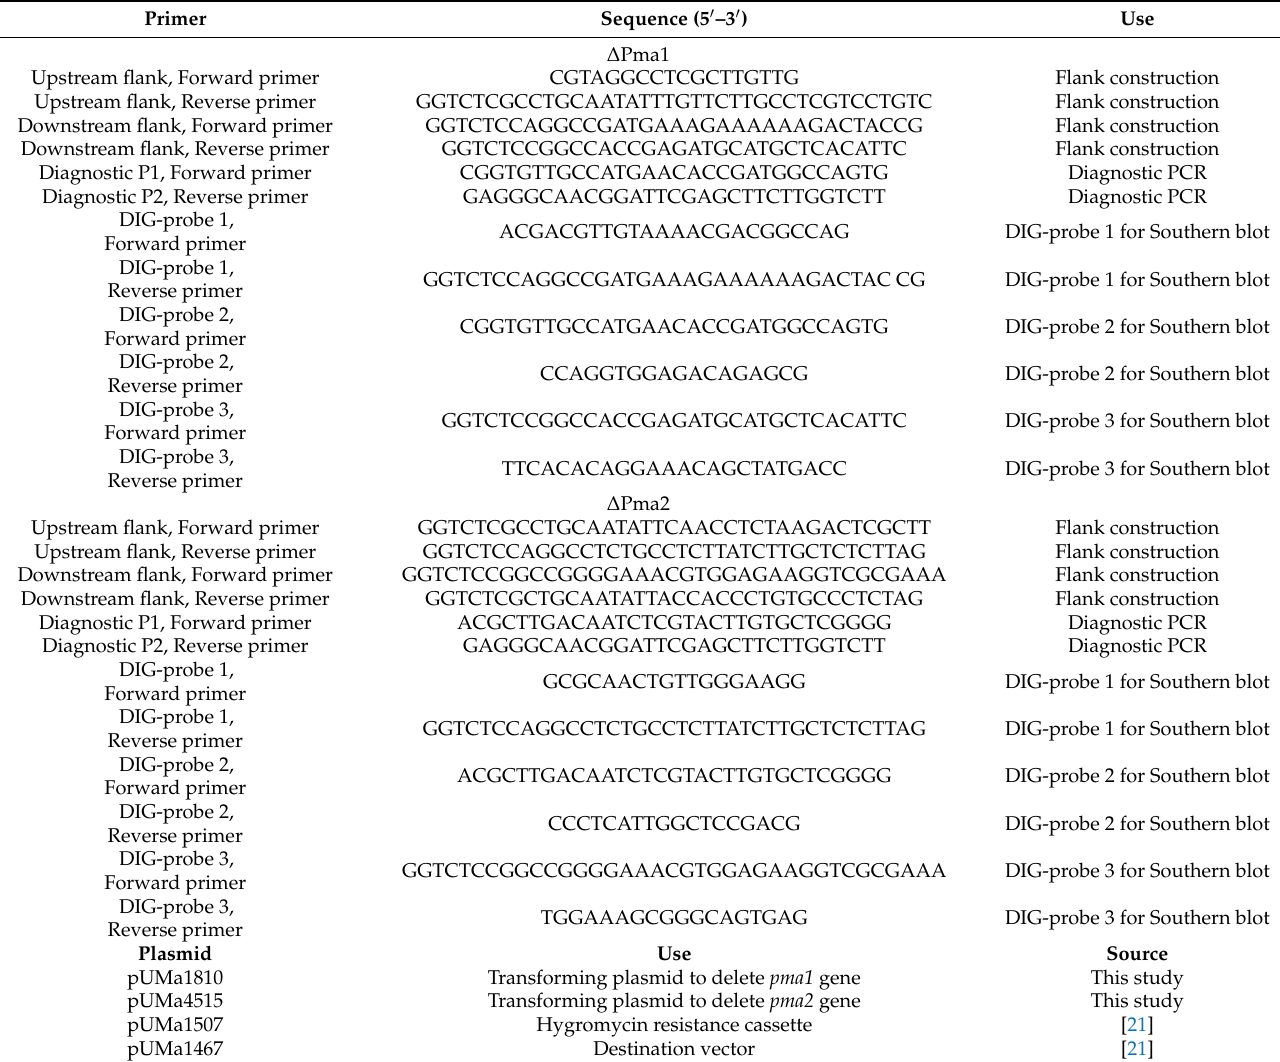
Table 2. Primers and plasmids used in this